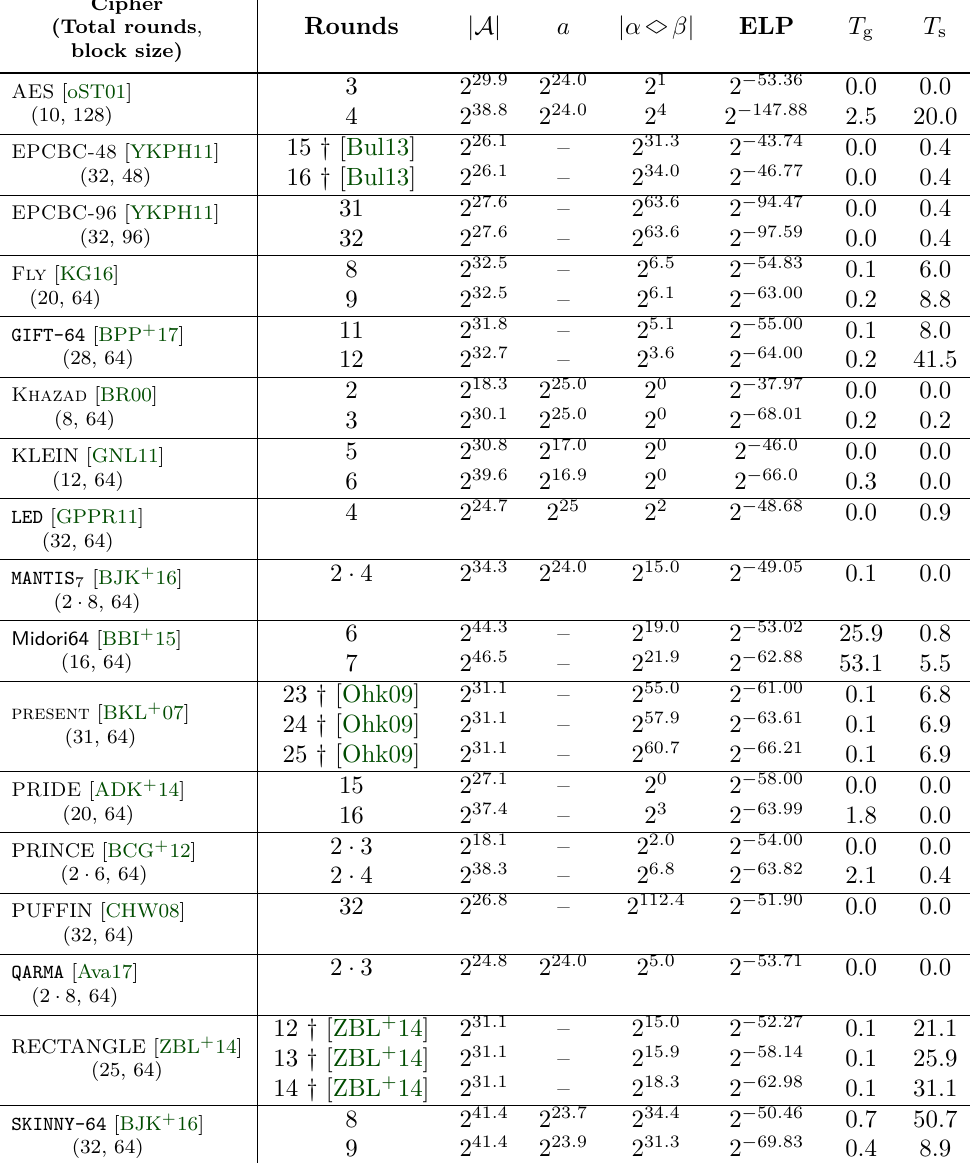
Table 1: Result for linear cryptanalysis obtained using the algorithm presented in this work. A is the set of single round approximations considered, a is the number of anchor vertices used, α ♦ β is the set of trails found for the best approximation, ELP is the expected squared correlation for the best approximation, and T g and T s is the time in hours to generate and search through the graph, respectively. Entries annotated by † indicates an improvement over a previously published